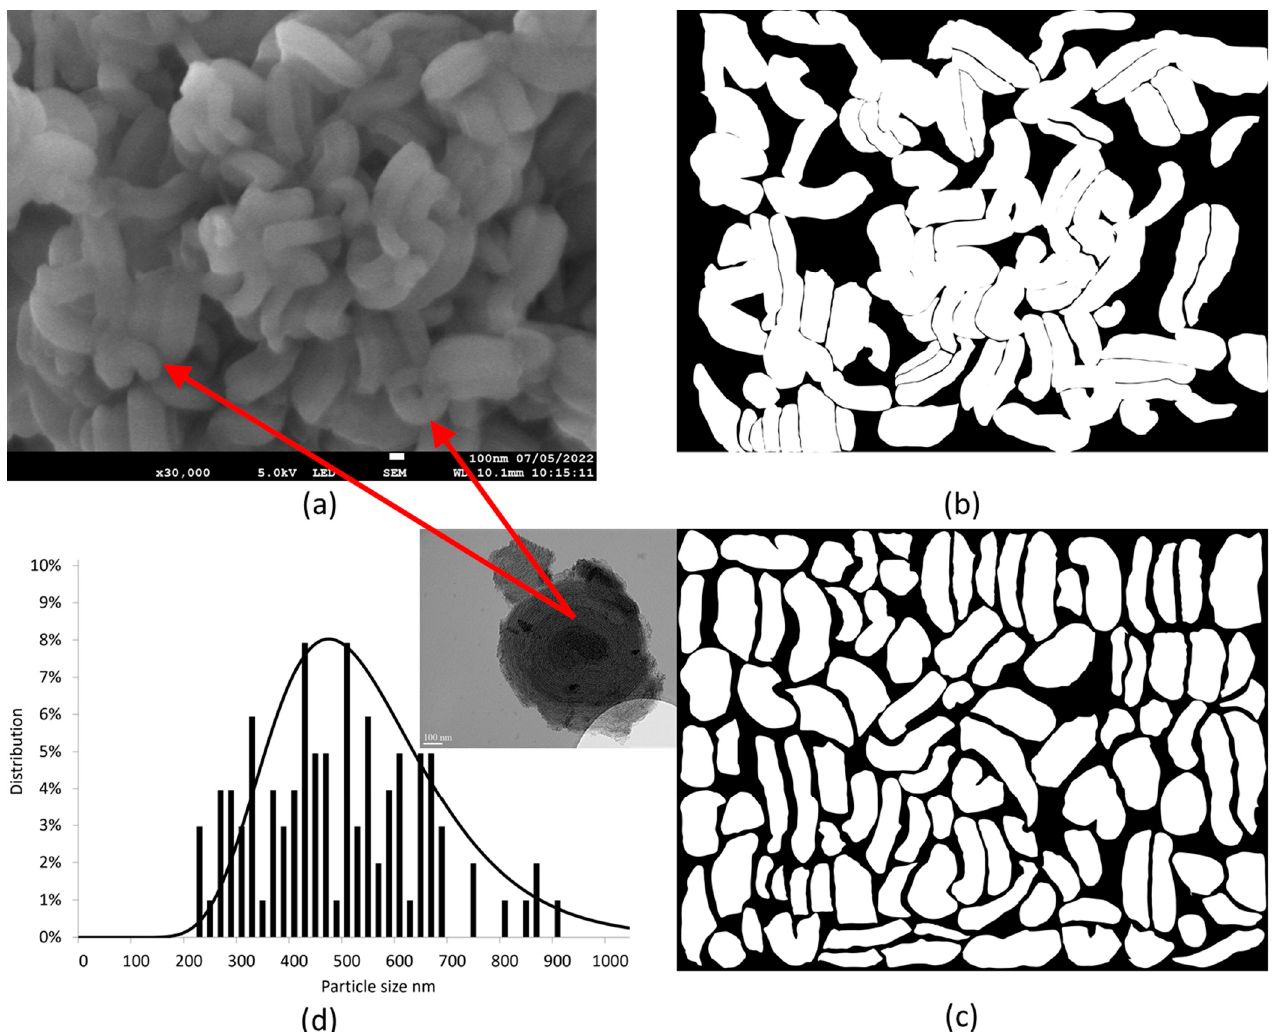
Figure 8. Methodology to obtain the distribution of particle sizes (example of an un-milled SBA-15 powder sample): ( a ) raw SEM micrography; ( b ) corresponding particles traced with hand; ( c ) isolation of particles; ( d ) corresponding distribution of particle sizes. Red arrows show local observations from TEM experiments, in various regions of the SEM micrography